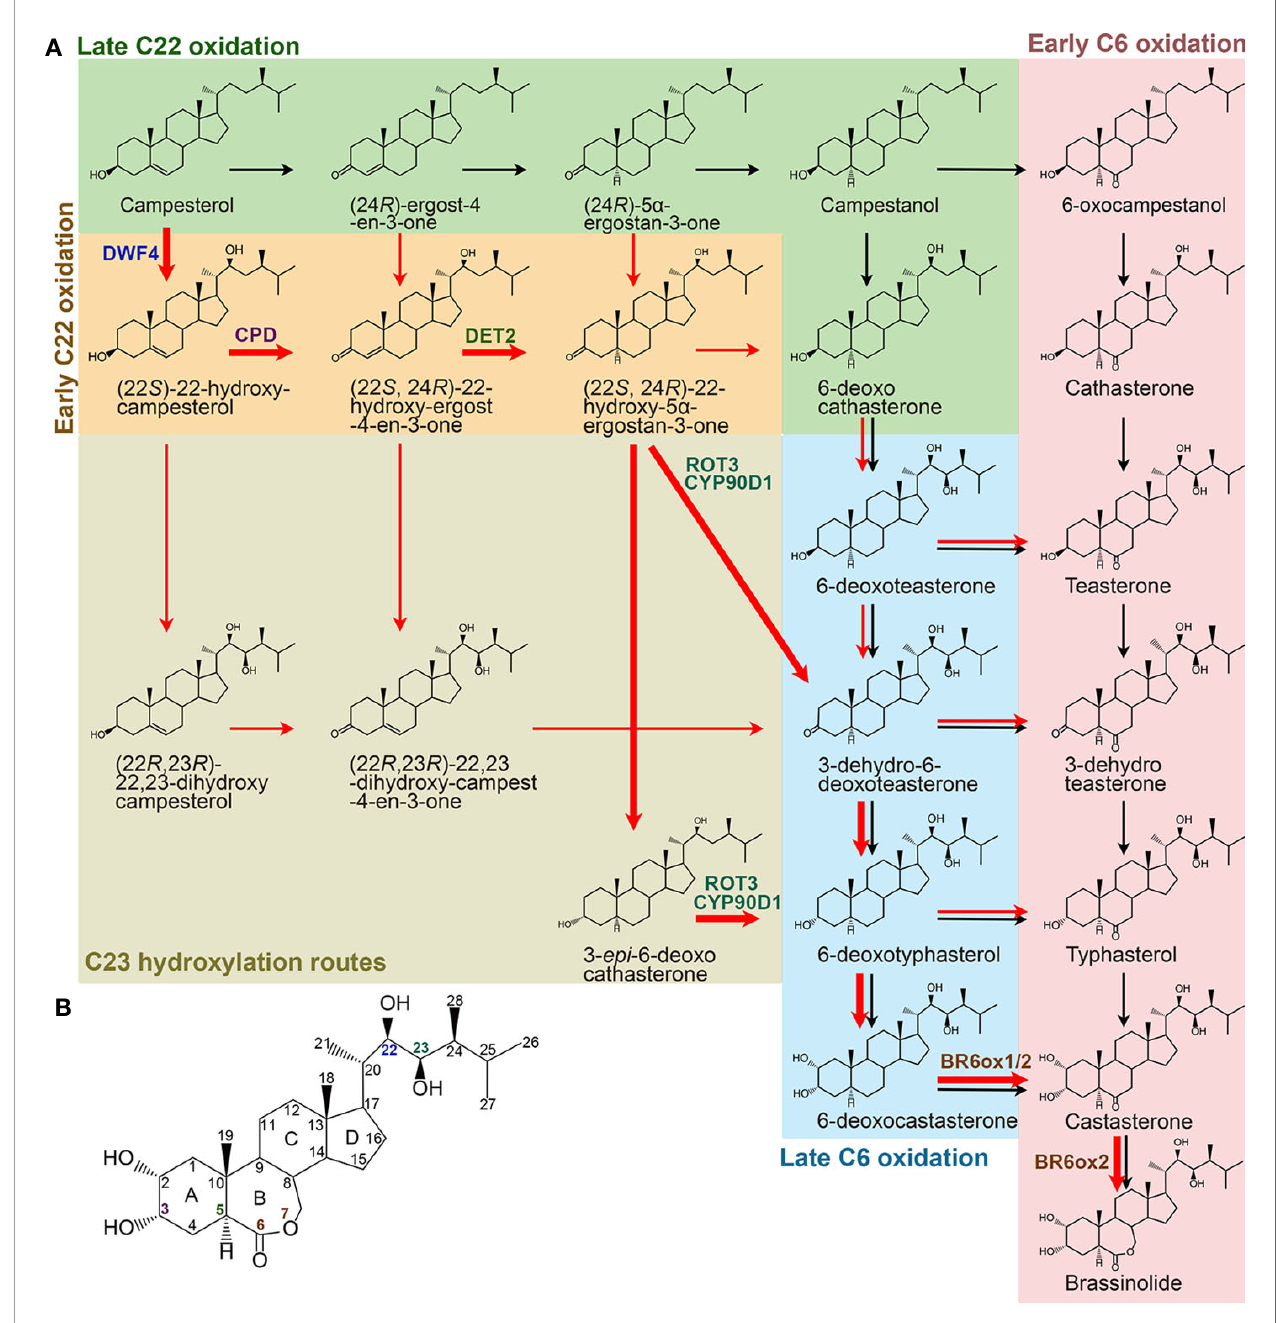
FIGURE 2 | Speci fi c BR biosynthetic pathways from campesterol in higher plants. (A) Black and red arrows represent CN-dependent and -independent pathways, respectively. Bold red arrows represent the most dominant and ef fi cient fl ow of the BR intermediates. Enzymes identi fi ed from Arabidopsis are only shown in the dominant routes. (B) Molecular structure of BL. The carbons are numbered and the rings are labelled by letters. Colors of the number correspond to the enzymes shown in (A)